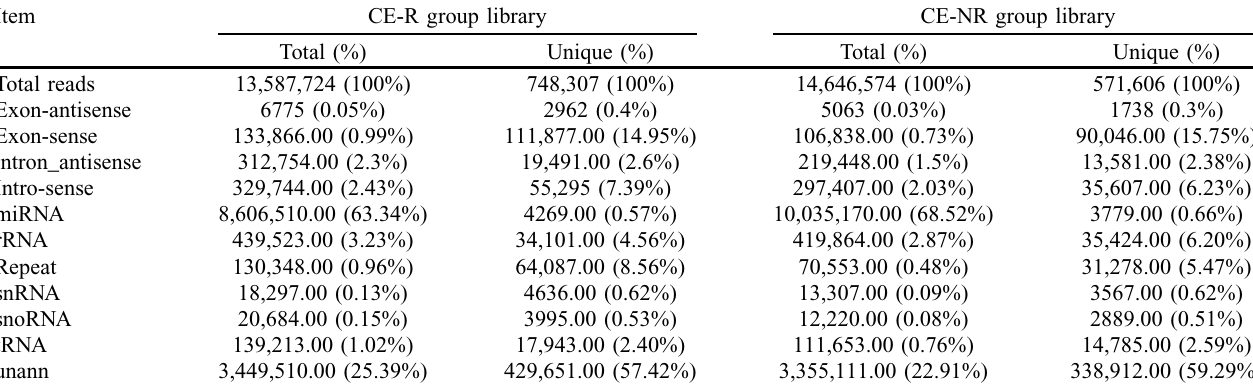
Table 1. Summary of reads from raw data to cleaned sequences for small RNAs in CE-R versus CE-NR in sheep. Item CE-R group